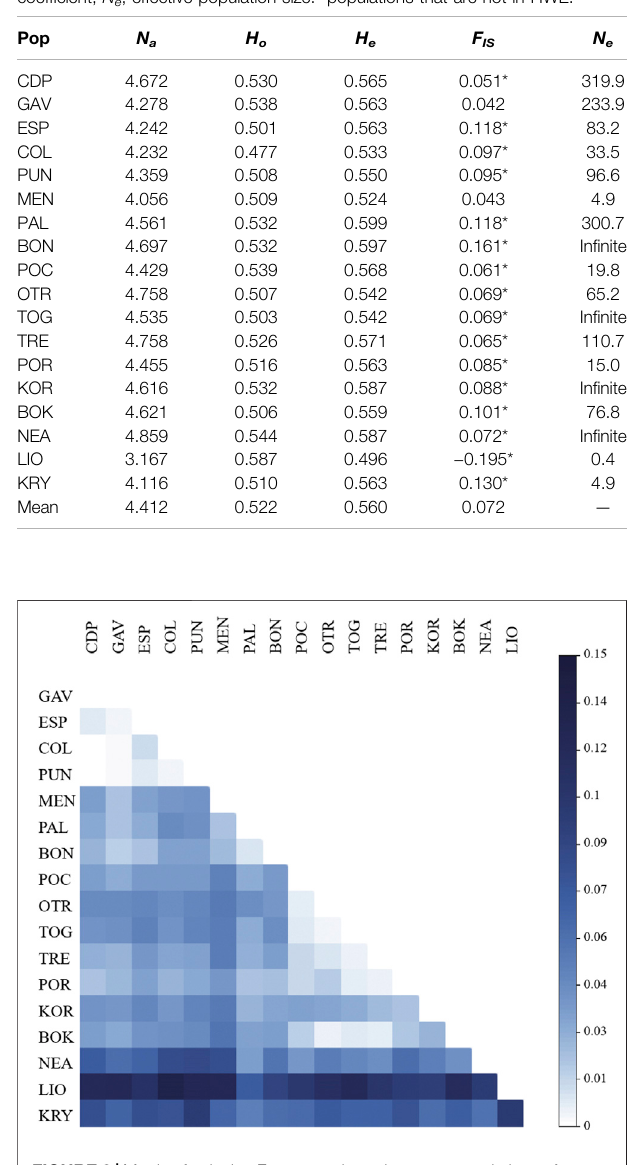
FIGURE 2 | Matrix of pairwise F ST comparisons between populations of C. caespitosa